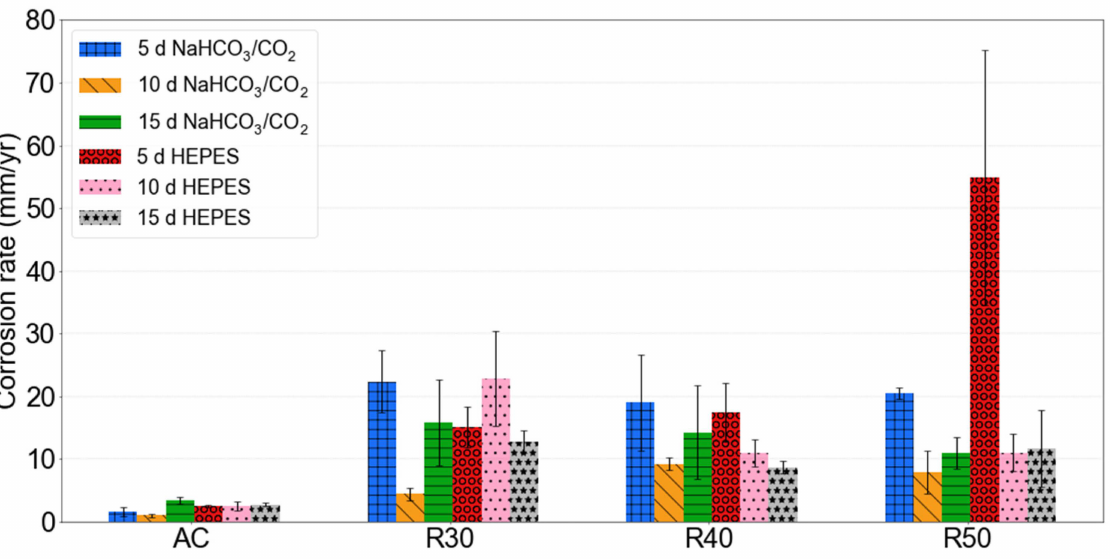
Figure 4. Mass loss derived corrosion rate results for AC and RX samples after 5, 10 and 15 d immersion in NaHCO 3 /CO 2 and HEPES buffered EBSS. Error bars indicate 95% confidence